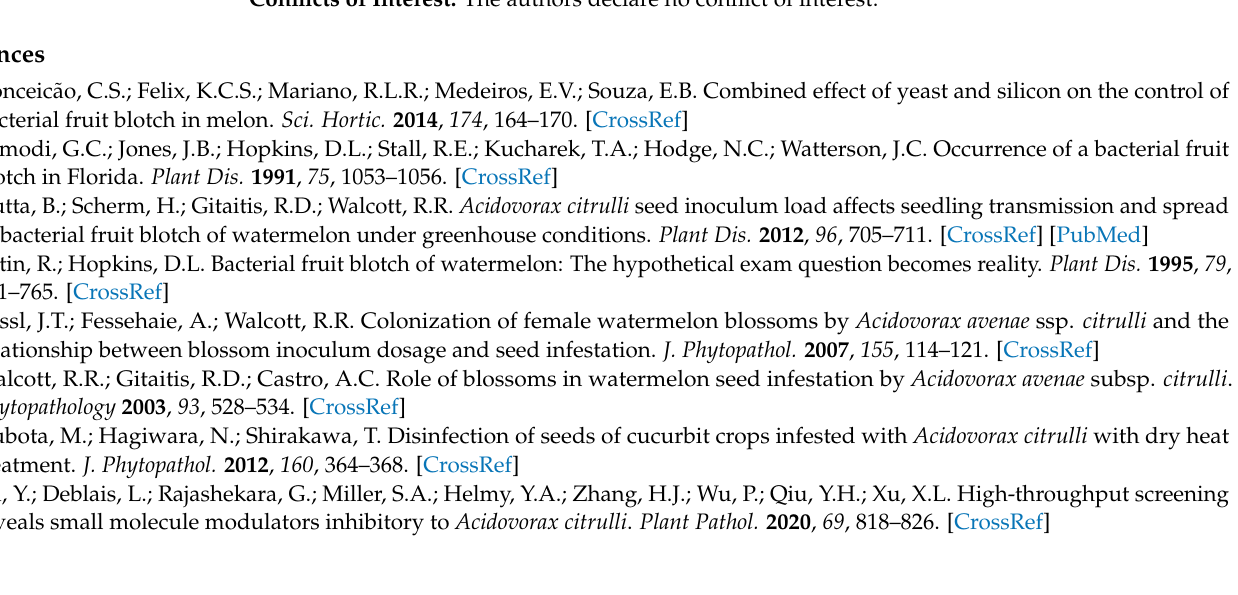
Figure S4: Antibacterial activity of P. chlororaphis YL-1 on LB plates, Figure S5: Anti- Xoo activity of P. plates, Table S1: Strains, plasmids and primers used in this